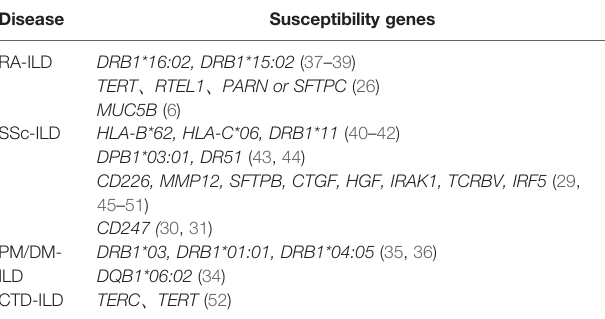
TABLE 1 | Susceptibility genes in CTD-ILD.